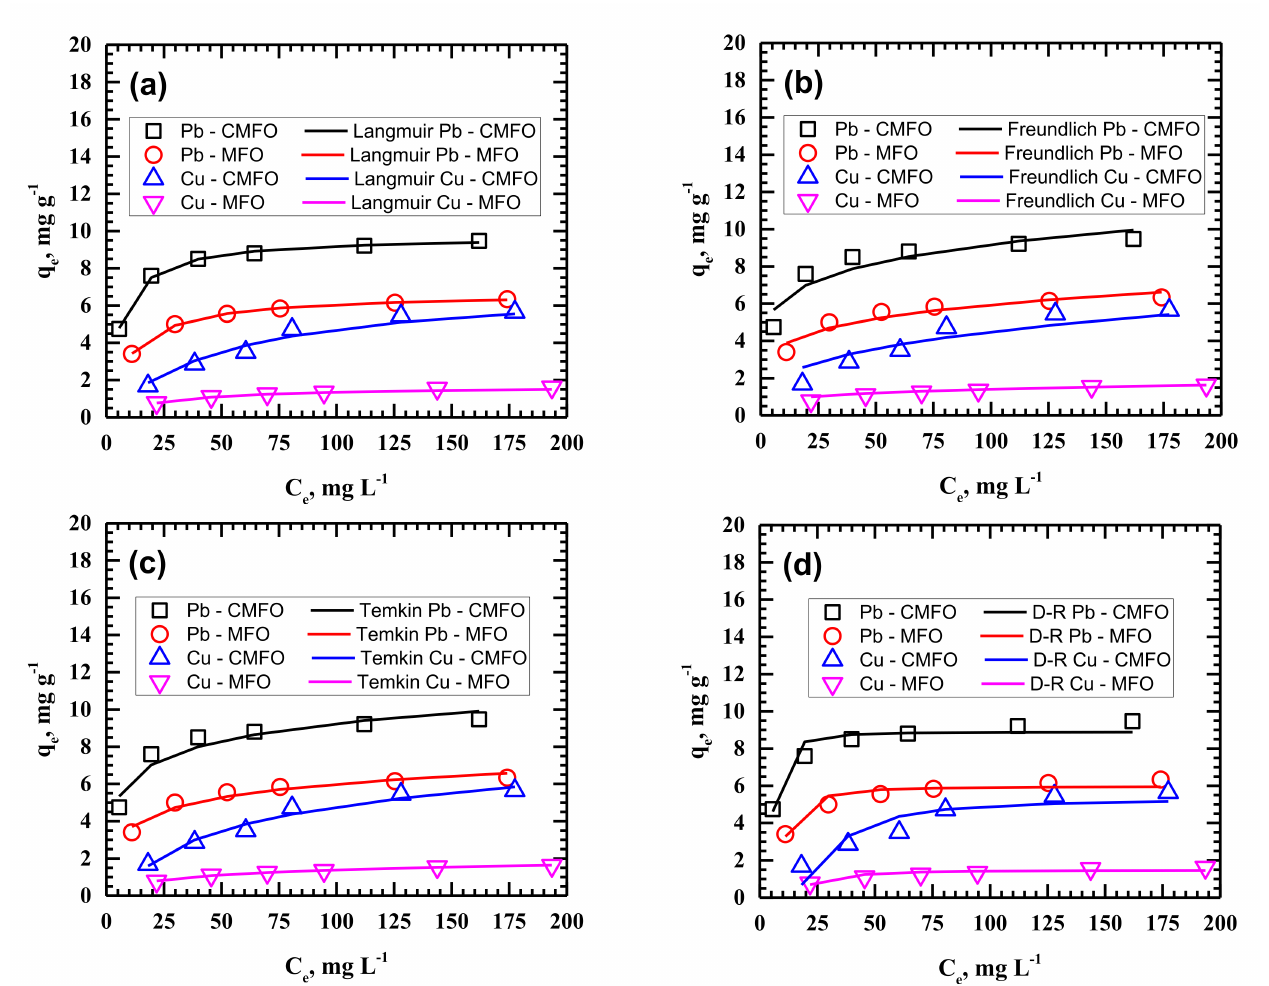
Figure 6. Nonlinear fitting of ( a ) Langmuir, ( b ) Freundlich, ( c ) Temkin, and ( d ) D-R isotherm models of Cu(II) and Pb(II) uptake by CMFO and